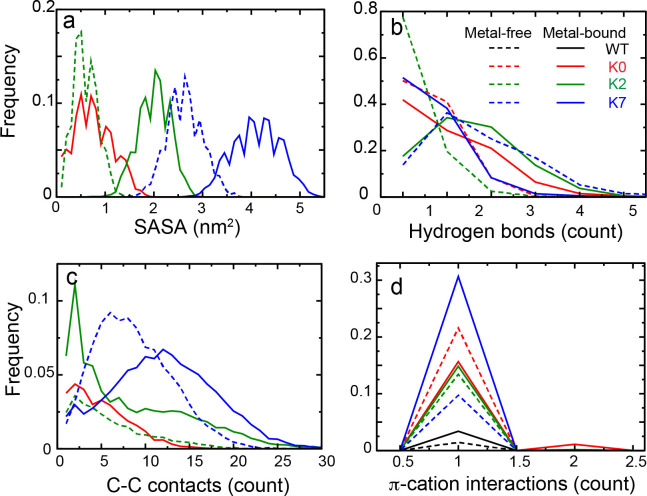
Distributions of various interactions of the C-linker Tyr residue nearest to the S6 helix, with the membrane interface for WT hSlo1 and mutants derived from simulations.(a) Tyr side chain SASA (Solvent Accessible Surface Area) of burial by lipid tails. (b) Hydrogen bonding of Tyr OH with the lipid polar head groups. (c) Carbon-carbon contacts between the Tyr aromatic ring and lipid tails. (d) π-cation interactions between Tyr aromatic ring and POPC choline groups. Distributions derived from simulations of metal-free and bound states are shown in dashed and solid lines, respectively. No hydrophobic, hydrogen bonding, or C-C contacts as defined above were observed in the WT channel. See Materials and methods for the details of the calculations.